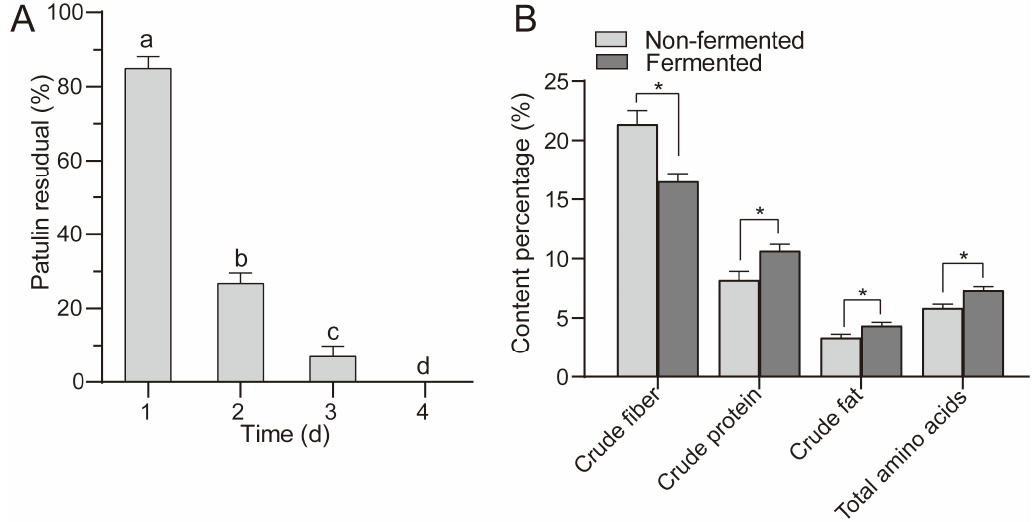
nutrients in the fermented and non-fermented apple pomace feed. Different letters indicate a